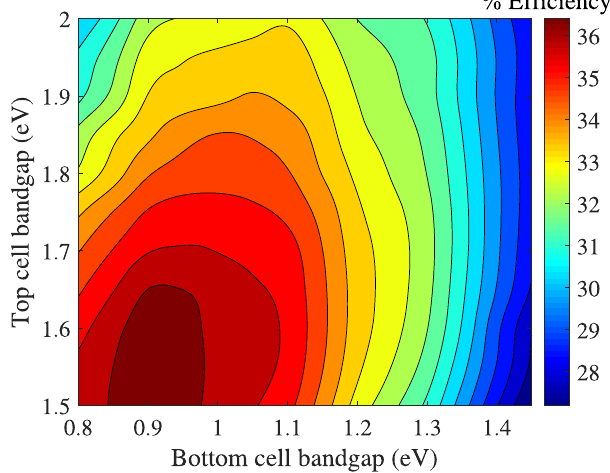
Fig. 7. 4T tandem solar cell ef fi ciency for different bandgaps of top and bottom cells, without considering trap-assisted recombi- nation losses. The thicknesses for both the top and bottom cells are fi xed at 350nm.